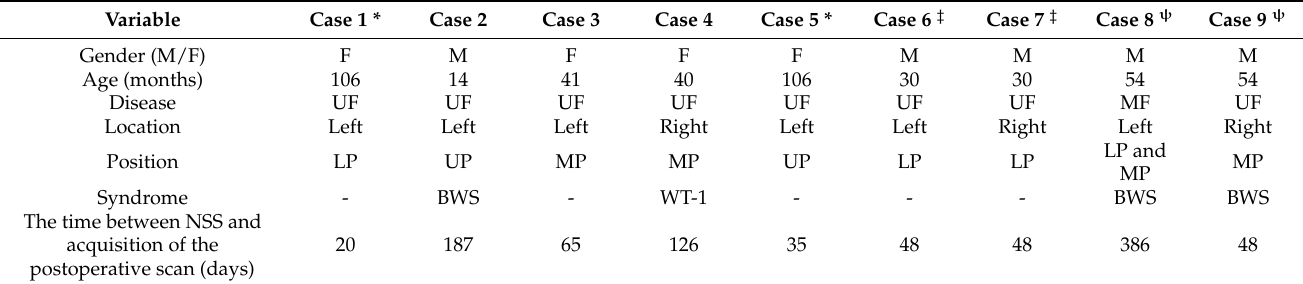
Table 1. The patient demographics, tumor characteristics and the time between the scans and surgery are listed for the nine operative